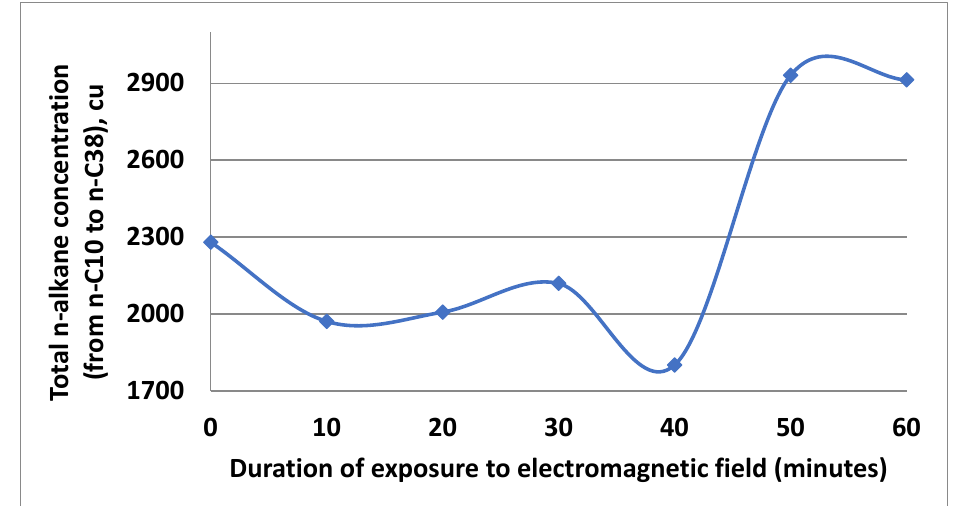
Figure 4. A time profile of N-alkane concentration of oil samples.